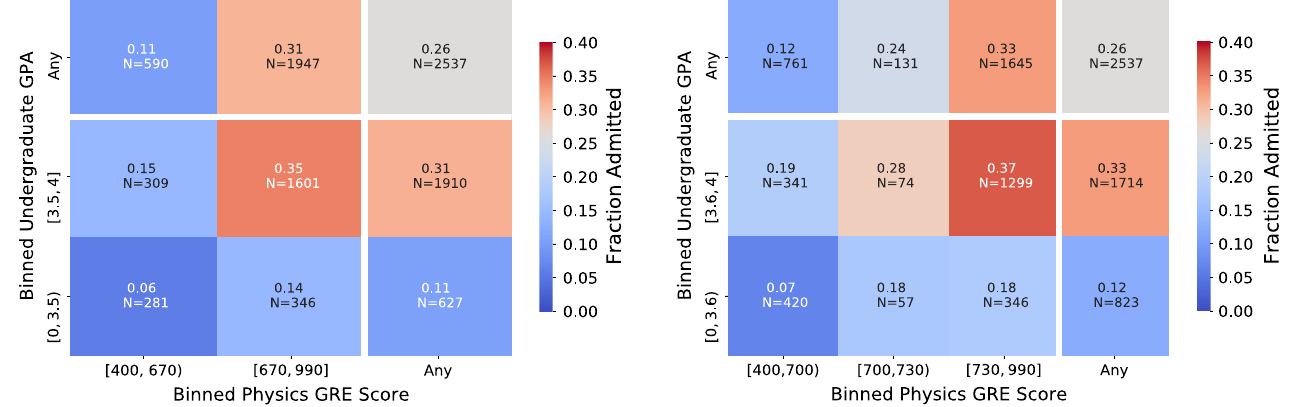
FIG. 14. A revised version of Fig. 4 showing the fraction of applicants admitted by undergraduate GPA and physics GRE score when the cutoff score for a high physics GRE score is 670.